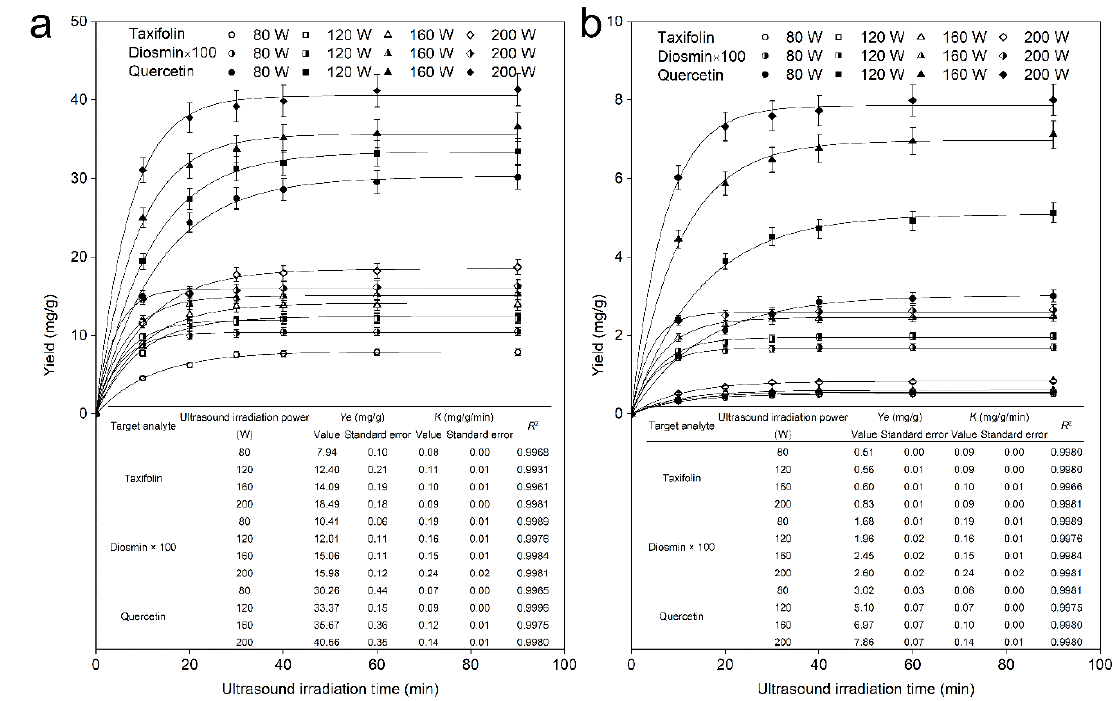
Figure 4. Dynamic curves for taxifolin, diosmin, and quercetin with various ultrasound irradiation powers (80 W, 120 W, 160 W, and 200 W) from Abies nephrolepis leaves ( a ) and bark ( b ).